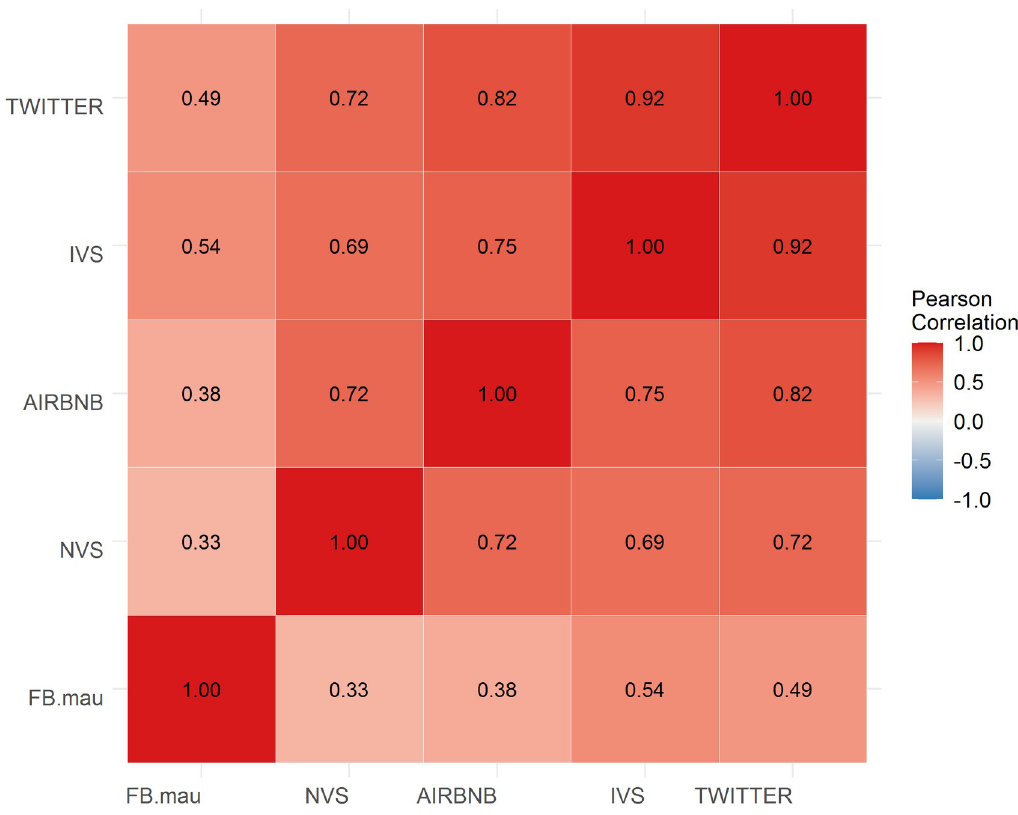
Fig 1. Correlation matrix heat map of candidate data sets. Source: authors’ own